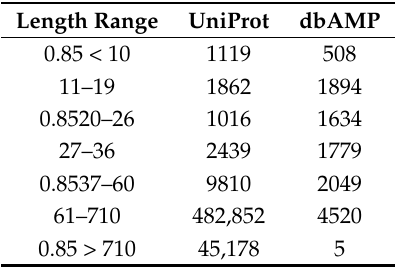
Table 1. Peptide and protein length distribution in the UniProt [38] and dbAMP [39] database divided into length groups according to the AmpGram benchmark dataset (for details, see Section